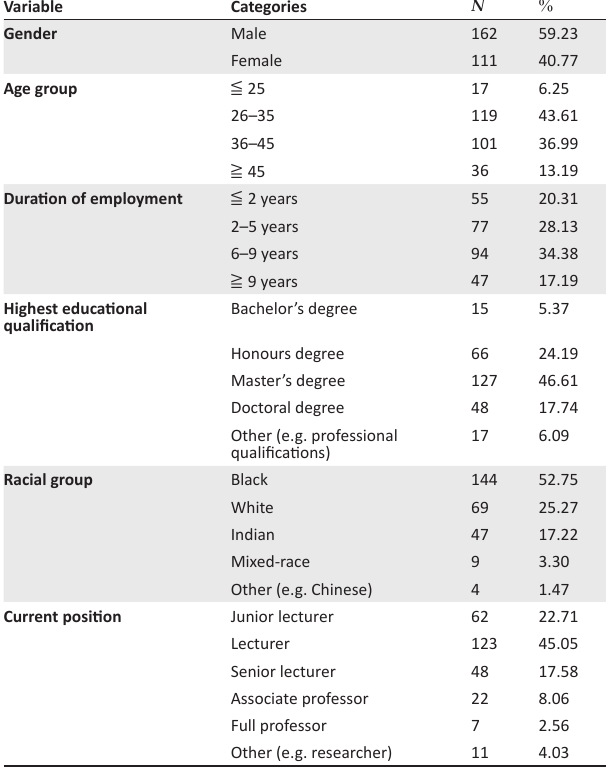
TABLE 1: Demographic profile of respondents ( N = 273)